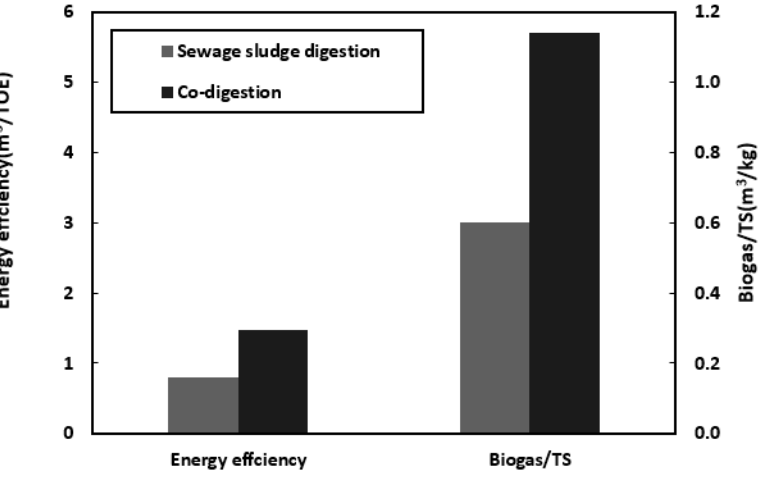
Figure 6. Energy efficiency and biogas production yield of only SS-AD and Co-AD. The bright bar is a facility that AD only SS, and the black bar is a facility that AD food and livestock manure